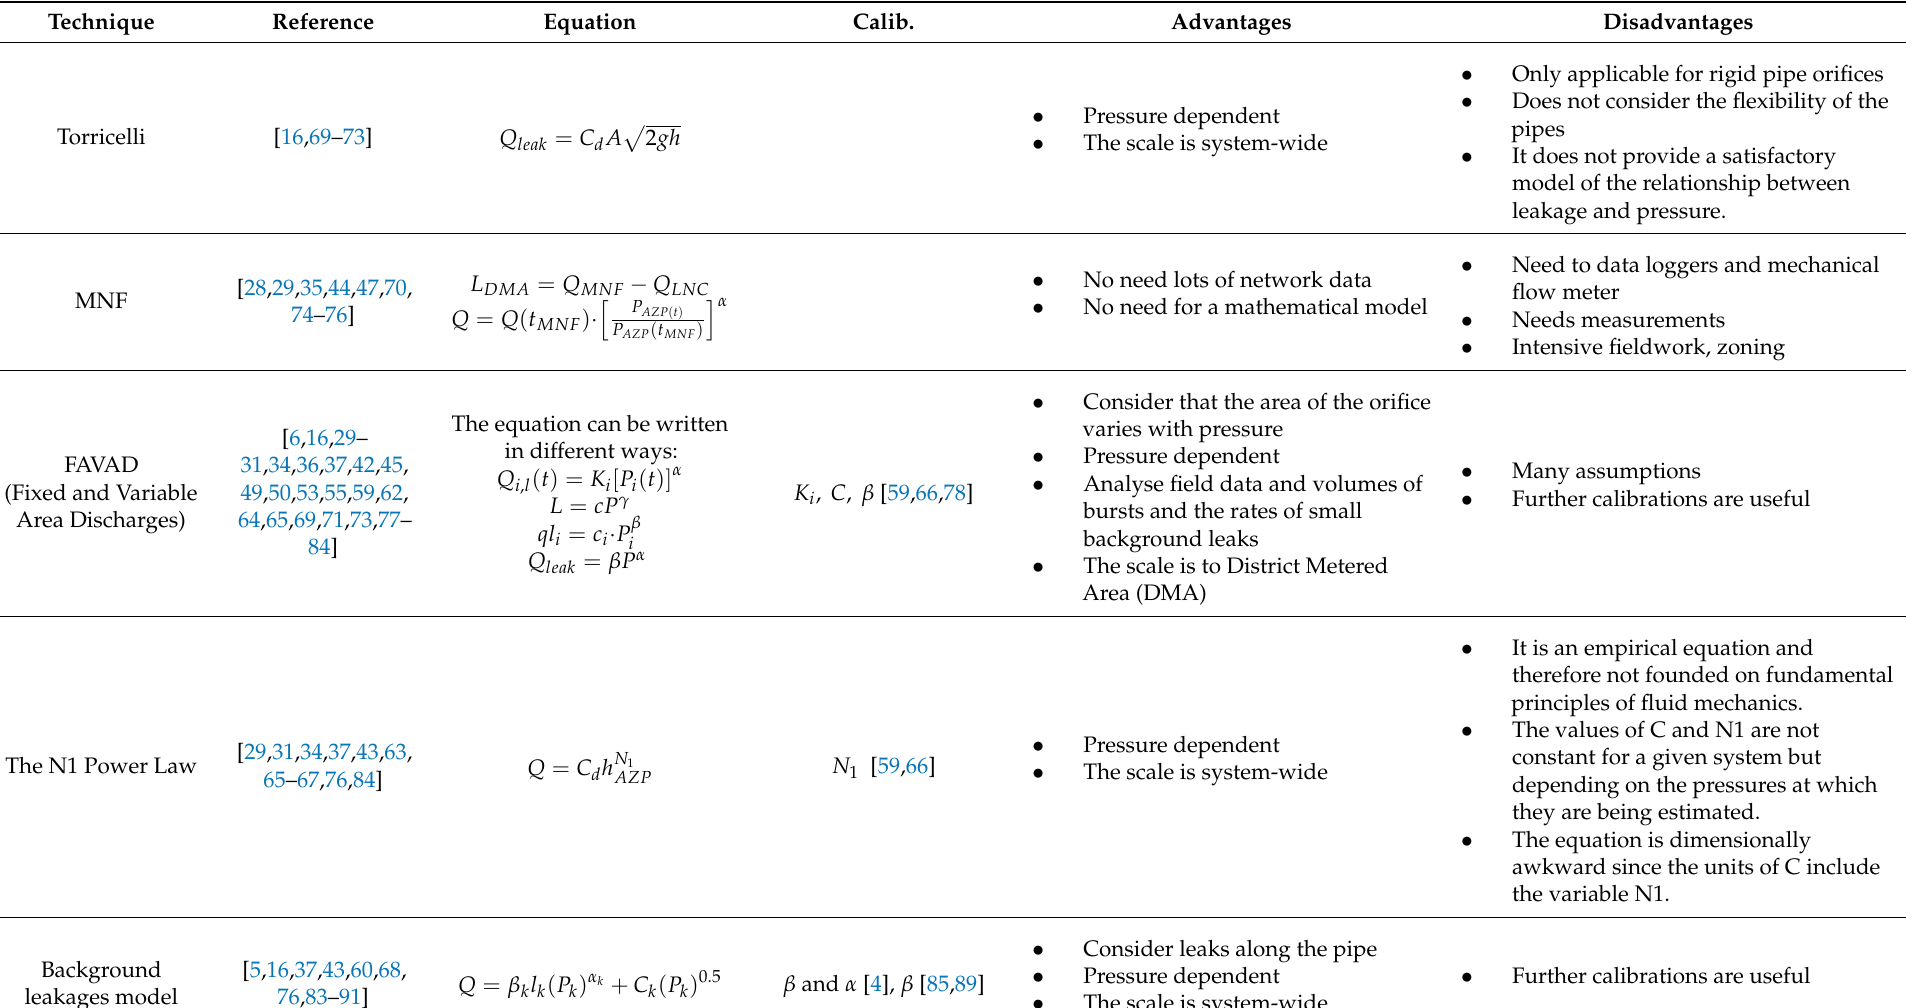
Table 4. Methodologies for calculating